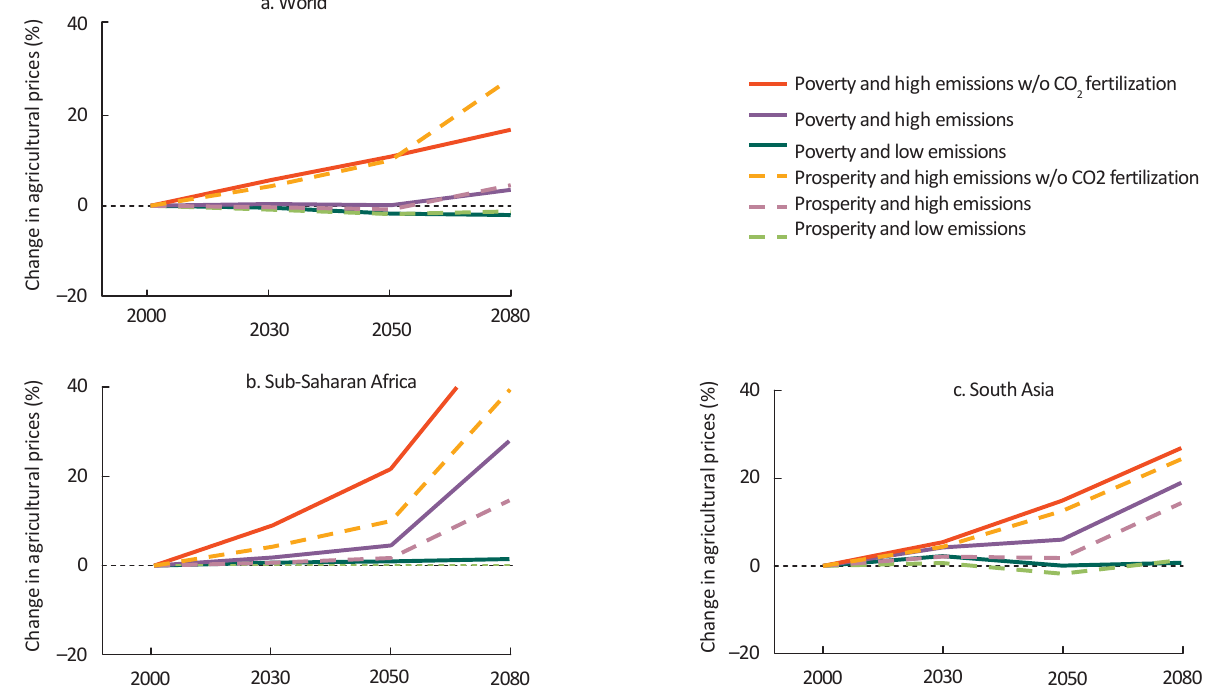
Figure 2: Effect of climate change on agricultural prices under different scenarios (source: Hallegatte et al. 2016)